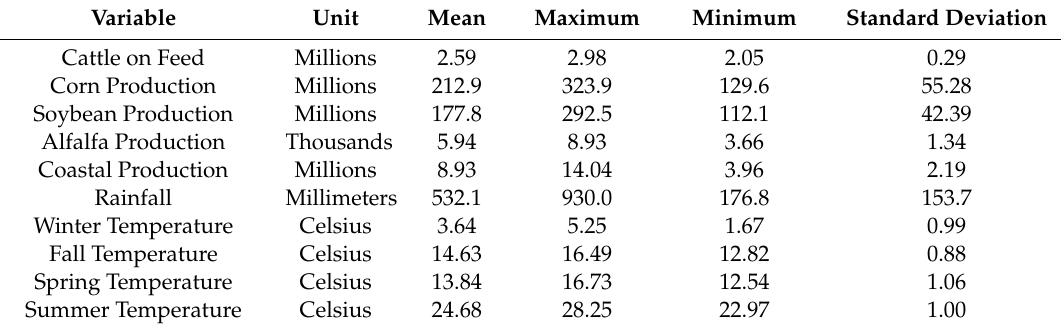
Table 1. Descriptive statistics for cattle Texas production data from 1985 to